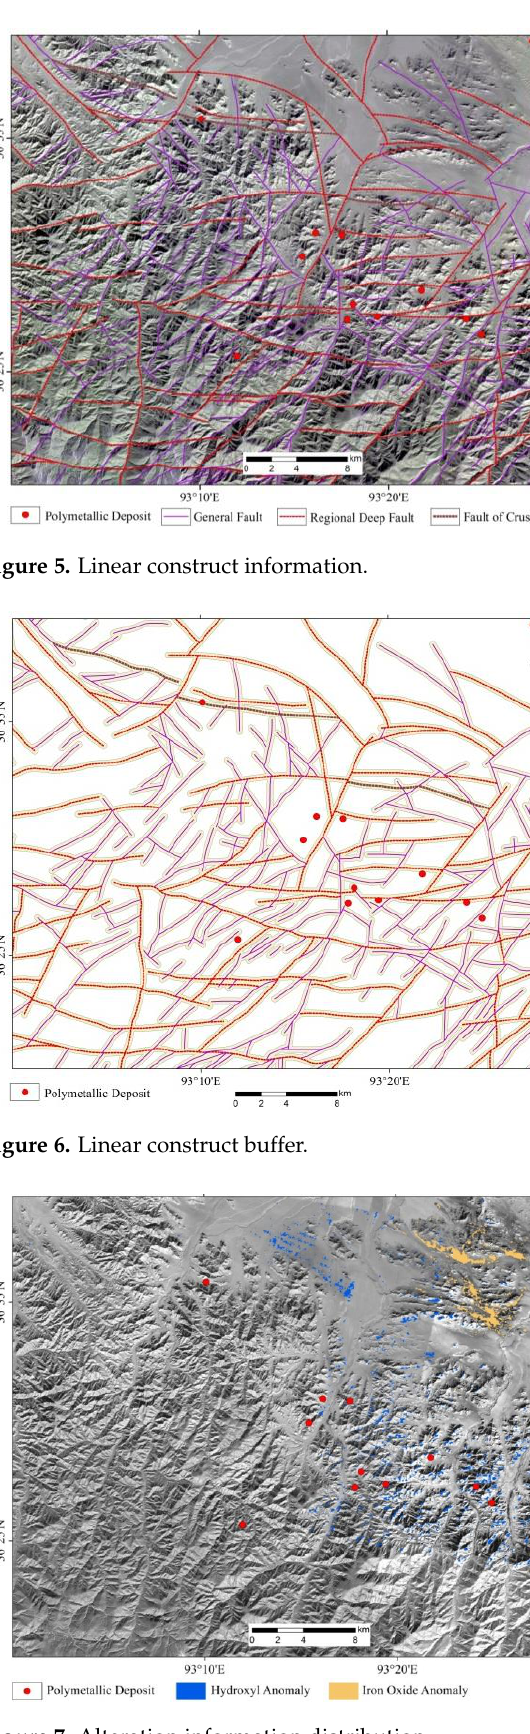
Figure 7. Alteration information distribution.